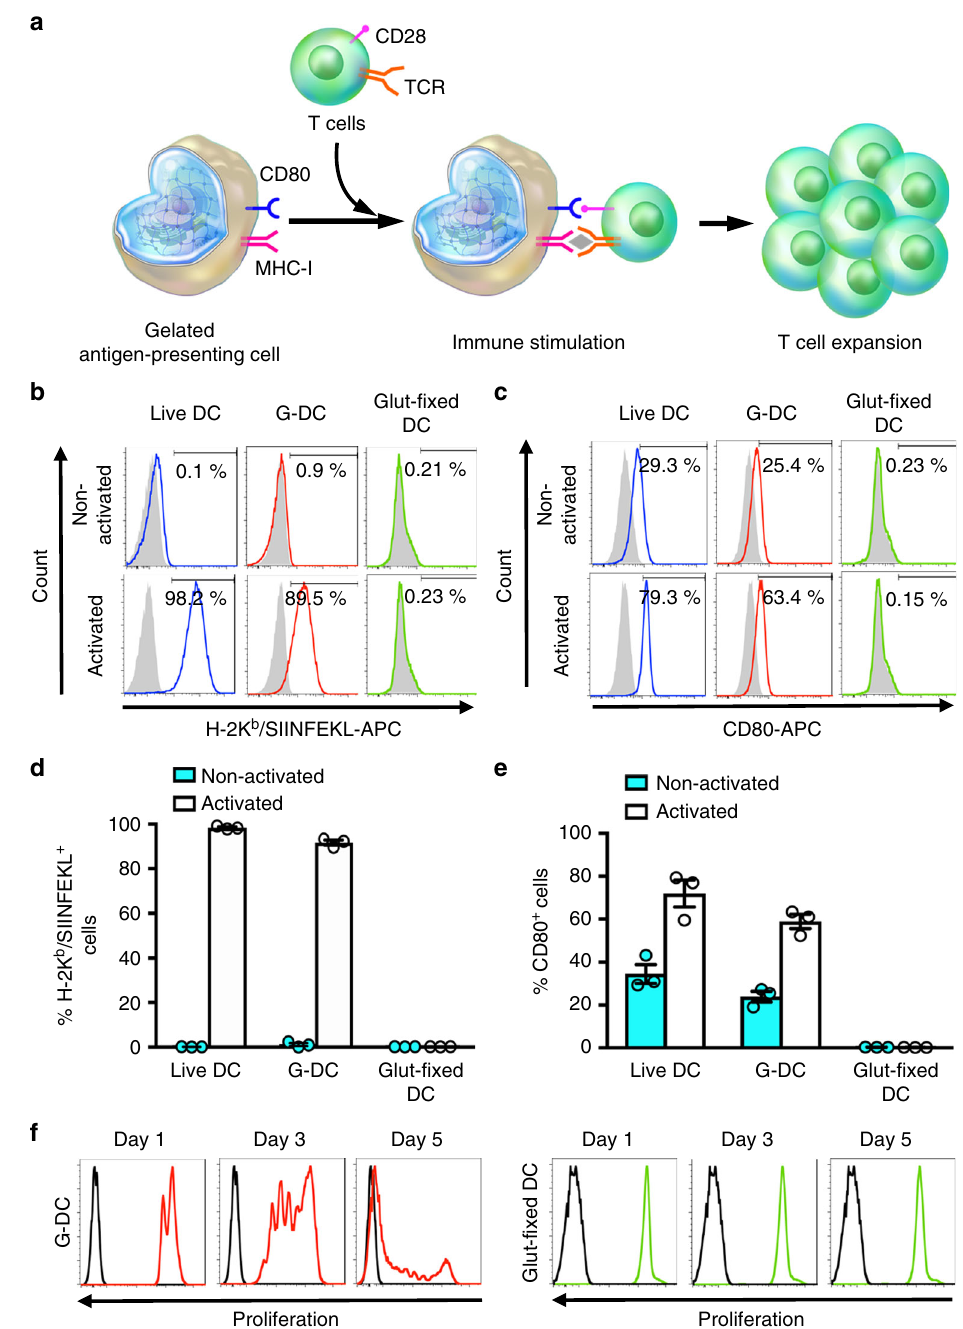
Fig. 5 Gelated dendritic cells (G-DCs) as arti fi cial antigen presenting cells. a A schematic illustration showing the interaction between T cells and G-DCs. JAWSII cells were treated with LPS and pulsed with SIINFEKL peptides for activation. Both nonactivated and activated cells were gelated for surface marker comparison. No signi fi cant difference was observed between the expression of b , d H-2K b /SIINFEKL complexes and c , e CD80 on the surfaces of live DCs and G-DCs. Unstained T-cell groups (gray) were used as a negative control. Error bars represent mean ± SEM, n = 3. f Co-culture of activated G-DCs and glutaraldehyde- fi xed DCs with CFSE-stained OT-I-speci fi c CD8 + T cells showed time-dependent T-cell expansion by the G-DCs but not by the glutaraldehyde- fi xed cells. Each culture condition contained a fi xed number of DCs at 8 × 10 4 per well with a T-cell/G-DC ratio of 3:1. Unstained control T cells are plotted in black as a Gelated APCs dynamically interact with T cells . T-cell inter- examined by incubating CD8 + T cells derived from OT-I action with activated G-DCs was visually examined through transgenic mice with activated G-DCs. The G-DCs effectively confocal microscopy. Upon incubation, multiple T cells were expanded the target T lymphocytes in a time- and cell ratio- observed to interact with G-DCs actively, forming cell – cell con- dependent fashion (Fig. 5f and Supplementary Fig. 16C, D), jugates (Fig. 6a and Supplementary Movie 8). Time-lapse imaging validating preservation of functional cell membrane interface revealed continuous morphological changes and movements by intracellular hydrogelation.